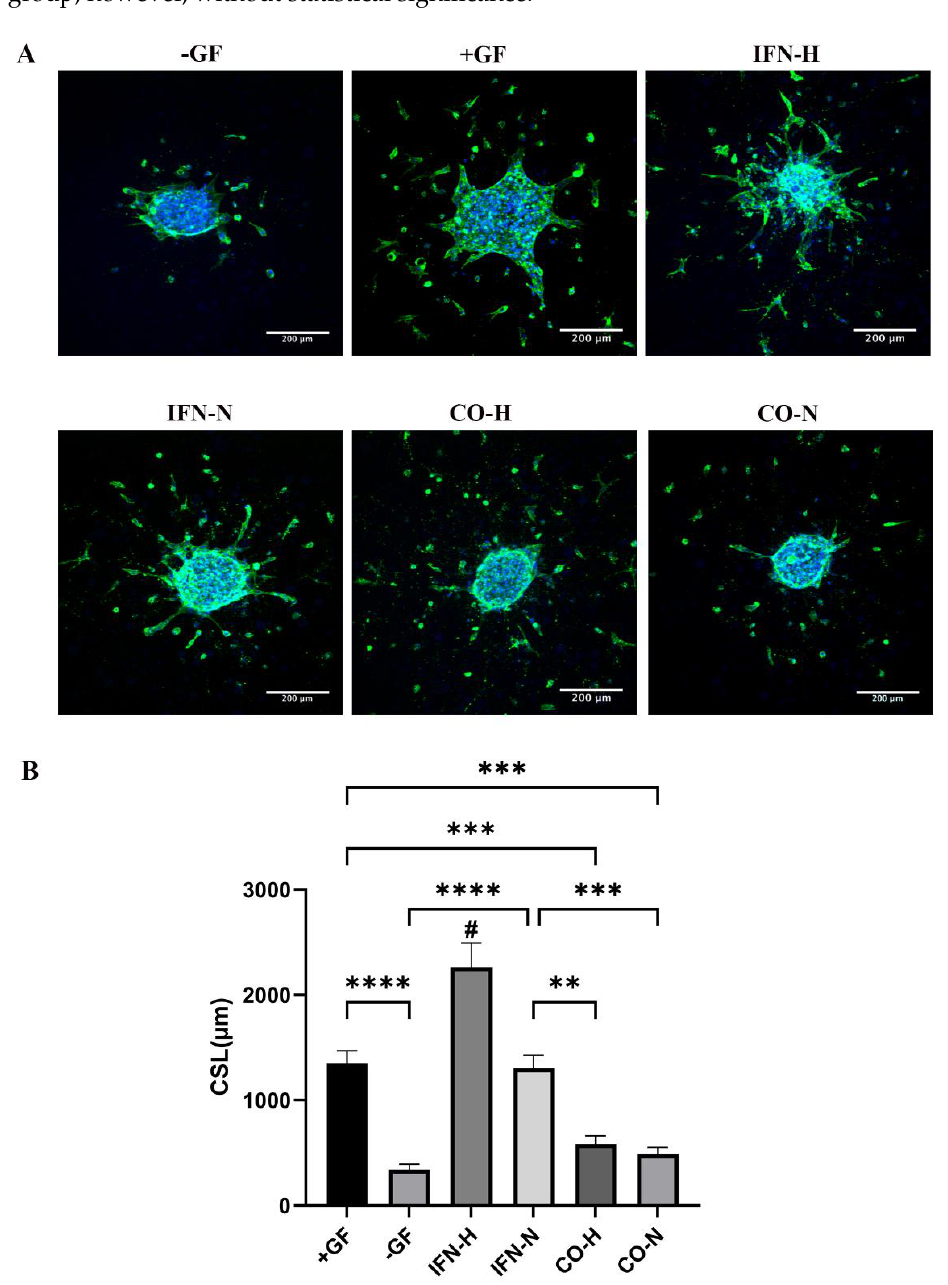
Figure 8. Sprout formation by 3D HUVEC spheroids cultured within coll/HA composites in the presence of iMSC secretomes for 48 h. ( A ) Representative confocal images (Alexa488-Phalloidin staining) of HUVEC spheroids cultured within coll/HA composites in the presence of differently pre-conditioned iMSCs secretomes in a 10x magnification (scale bar = 200 µm). ( B ) Quantification of cumulative sprouts length (CSL) analyzed using the ImageJ software. Mean CSL was calculated for at least 10 randomly selected spheroids per experimental group. Values represent means ± SEM from three independent experiments (# indicates that the IFN-H HUVEC group showed significant differences to all other groups, ** p < 0.01; *** p < 0.001; **** p < 0.0001). 4. Discussion MSCs have been widely explored for cell-based therapy in the field of tissue regen- eration due to their remarkable immunosuppressive and immunomodulatory properties